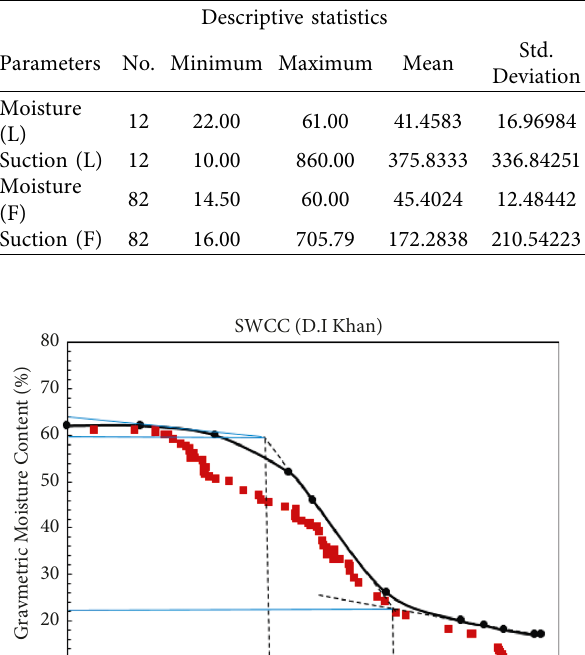
Table 3: Descriptive statistics for the measured parameters of D.I Khan expansive soils.